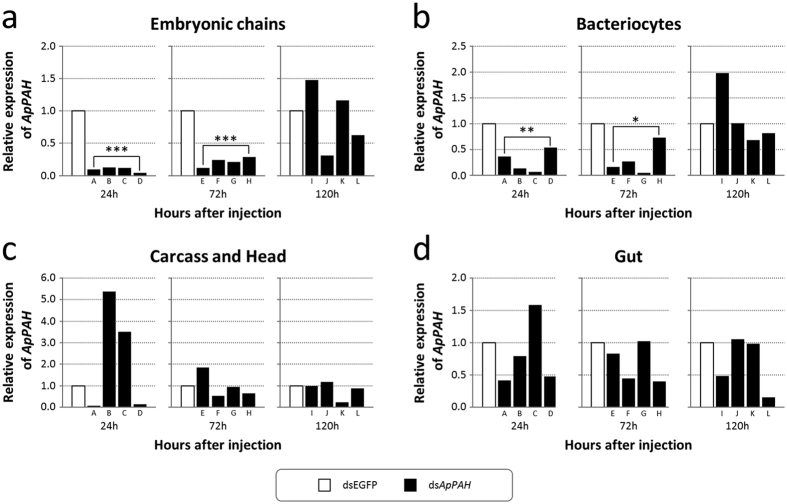
Knockdown analysis of ApPAH following dsRNA injection.(a–d) qRT-PCR determination of ApPAH expression levels in the embryonic chains (a), bacteriocytes (b), carcass and head (c), and gut (d) of dsApPAH-treated aphids, relative to expression levels of the dsEGFP controls. Each body compartment was analyzed from four individual aphids at 24 h (labeled A, B, C and D), 72 h (E, F, G and H), and 120 h (I, J, K and L) post-dsApPAH injection. The rpl7 and actin genes were used for data normalization. Data were analyzed with a unilateral Student’s t-test for down-regulations and significant results are indicated with asterisks (*P < 0.05; **P < 0.01; ***P < 0.001).